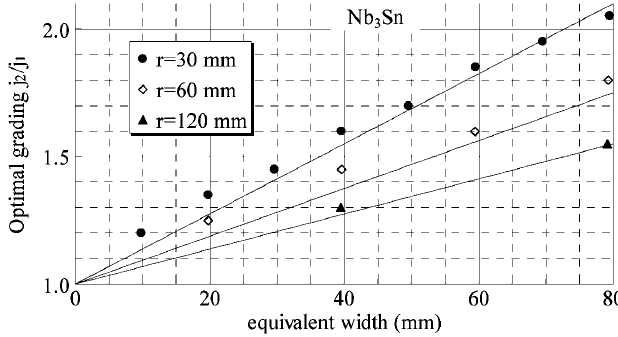
FIG. 11. Optimal grading as a function of the sector width, and Sn case, graded 3 (cid:5) (cid:1) 0 : 35 , Nb Sn 3